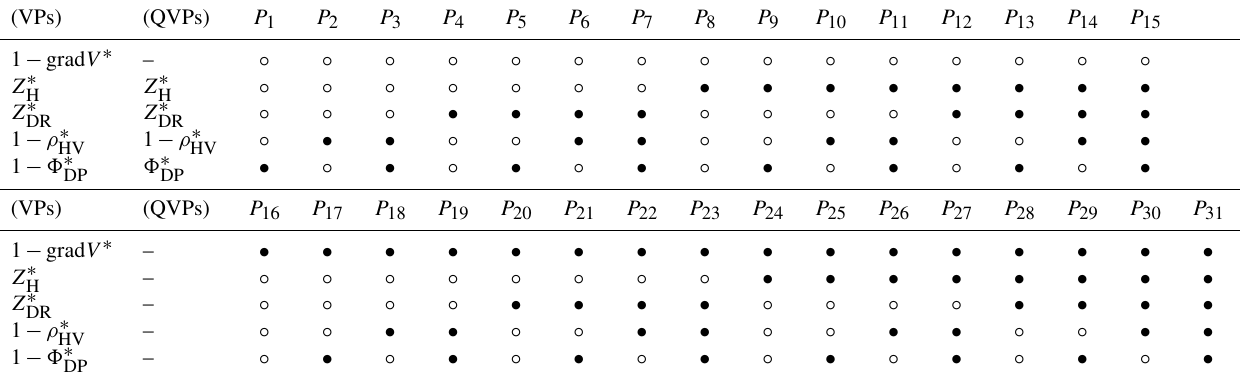
Table 2. Possible combinations of polarimetric variables for VPs and QVPs used for the ML detection.